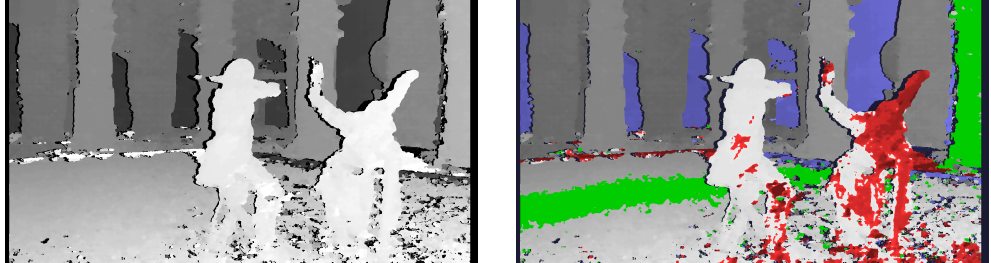
Figure 4. Calculated disparity map without image rectification—greyscale ( left ) and with depth budget constraints’ information ( right ).